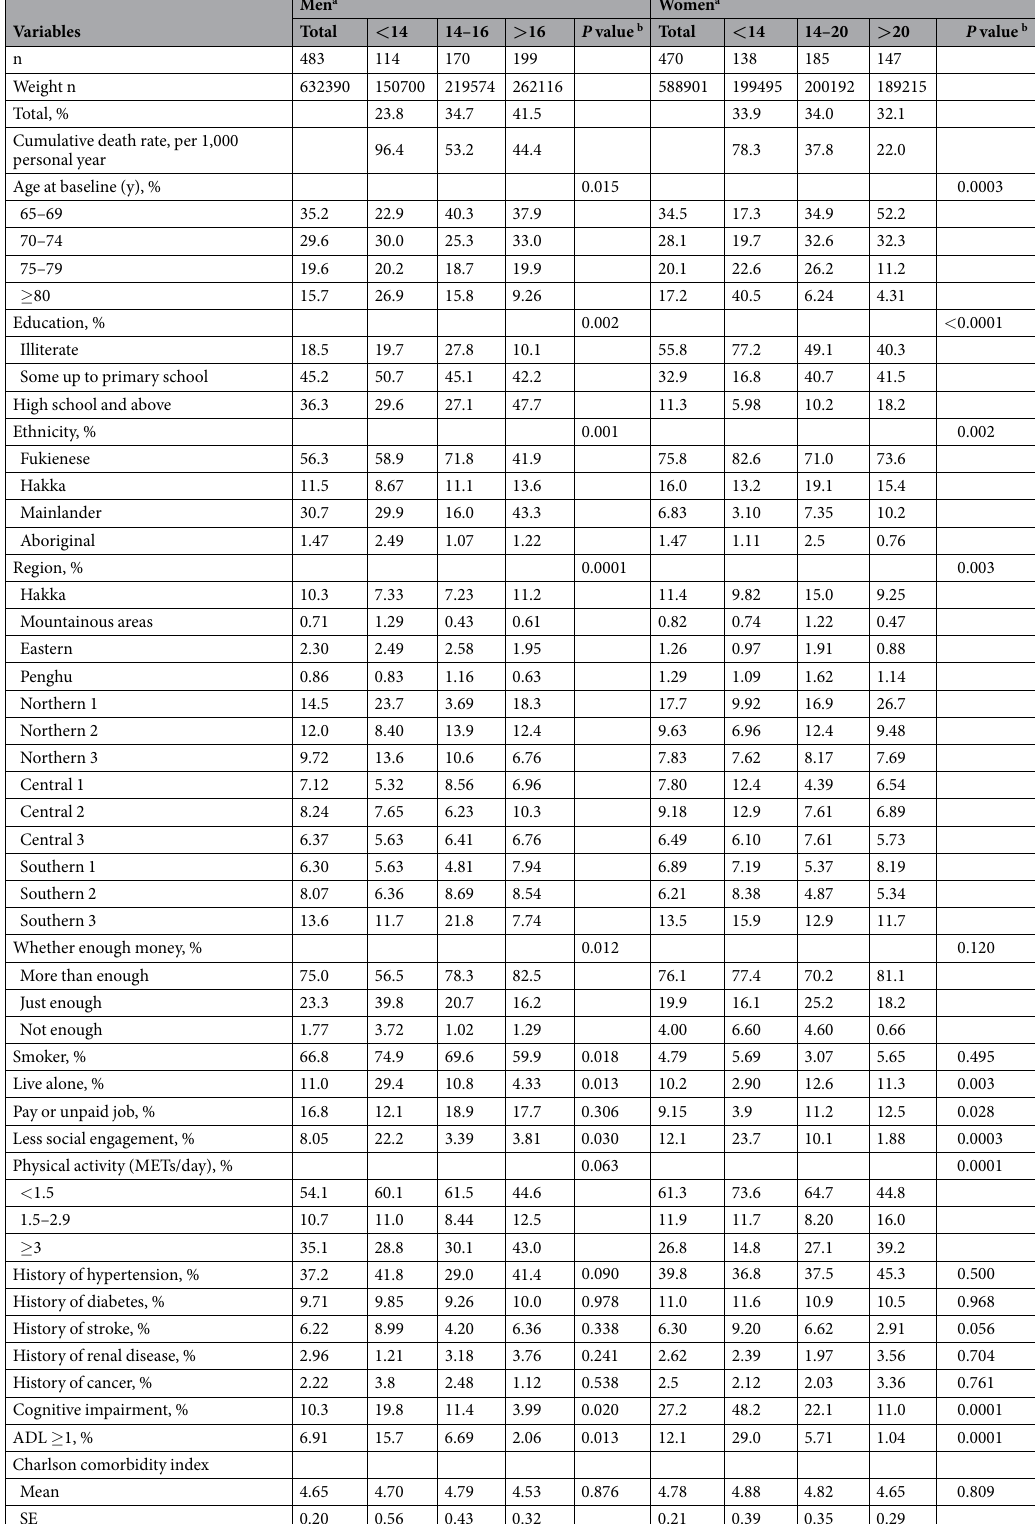
Table 3. Baseline characteristics of NAHSIT Elderly by the HANI in the validation set All data weighted for unequal probability of sampling design by SUDAAN. a Cut-off points for HANI were based on Youden index. b ANOVA and chi-square were used for continuous and categories variables to test difference between the HANI groups by gender. NAHSIT, Nutrition and Health Survey in Taiwan; HANI, Healthy Ageing Nutrition Index; METs, metabolic equivalents; ADL, activities of daily living; SE, standard